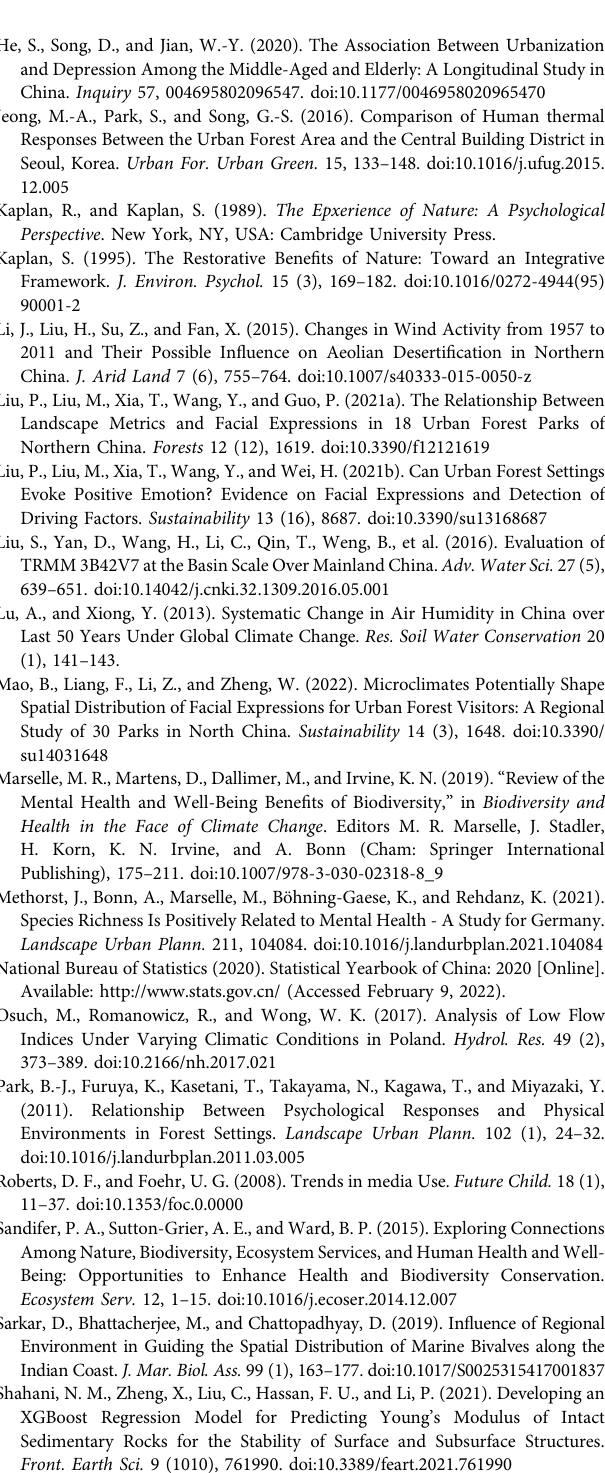
Figure S1 | Socio-economic dimensions of population (A), gross domestic product (GDP) (B), administrative area (C), and the distance of objective park to downtown of host-city (D) in host-counties/districts for wetland parks as study sites. Data are derived from National Bureau of Statistics (2020).